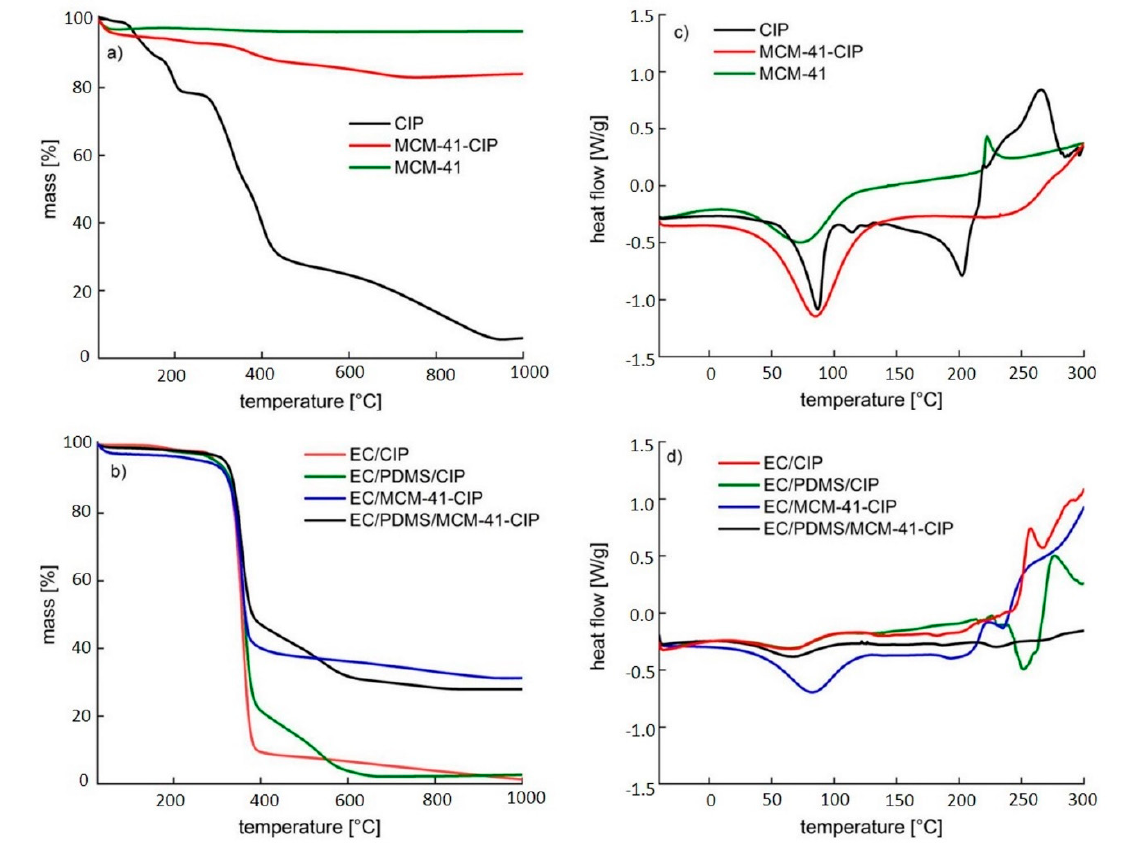
Figure 3. TG profiles normalized to the initial weight of freeze-dried CIP, MCM-41-CIP, and MCM-41 ( a ), TG normalized to the initial weight of the final composites: EC / CIP, EC / PDMS / CIP, EC / MCM-41-CIP, EC / PDMS / MCM-41-CIP ( b ), DSC curves normalized to the initial weight of freeze-dried CIP, MCM-41-CIP, and MCM-41 ( c ), DSC curves normalized to the initial weight of the final composites: EC / CIP, EC / PDMS / CIP, EC / MCM-41-CIP, EC / PDMS / MCM-41-CIP ( d ).